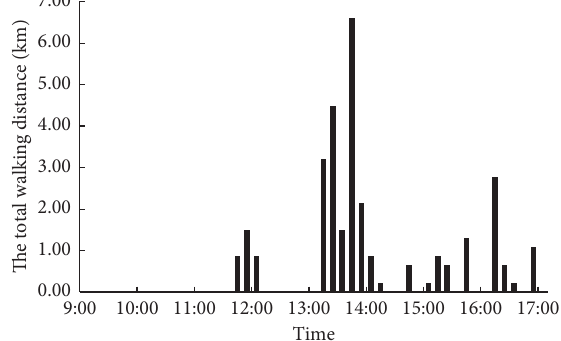
Figure 8: Total walking distance after parking from Le Song Plaza to Triumph